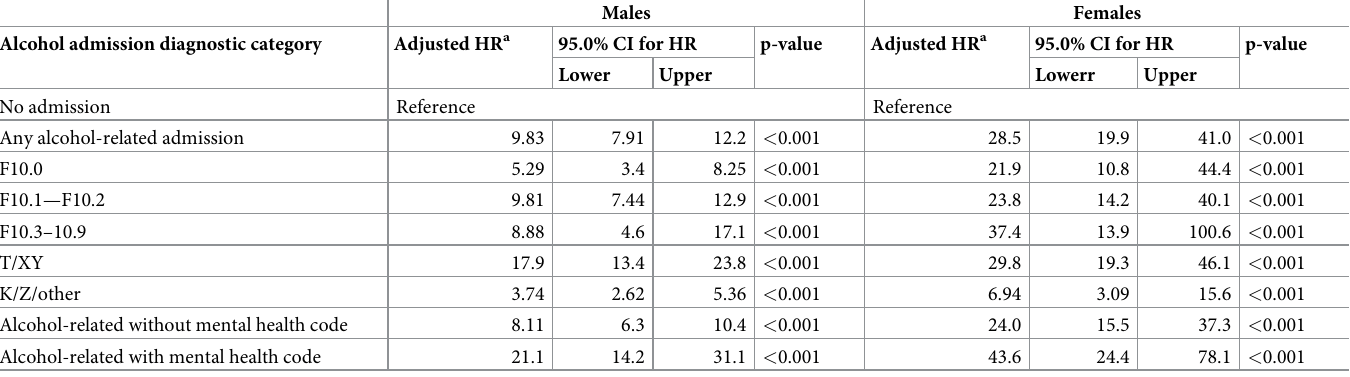
Table 3. Adjusted risk of death from suicide for categories of alcohol-related admission, stratified by